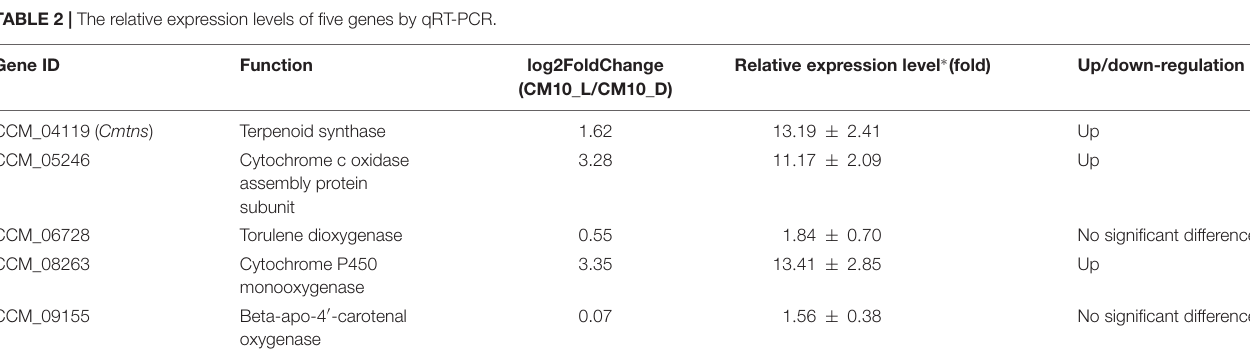
TABLE 2 | The relative expression levels of five genes by